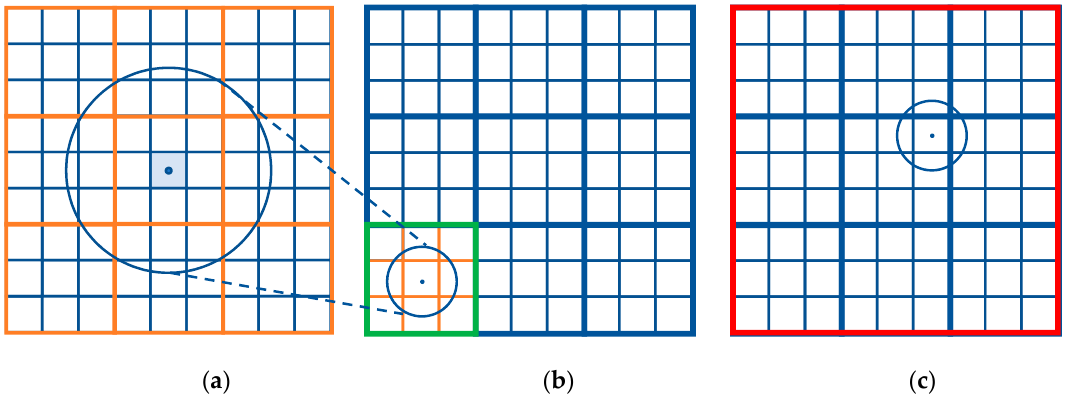
Figure 3. ( a ) A point, its quantized cell at resolution 𝑖 (shown in light blue), and an offset region. ( b ) The bounding cell of the offset region from ( a ) at resolution 𝑖 − 2 (shown in green). ( c ) The bounding cell of an offset region at a different location at resolution 𝑖 − 3 (shown in red).